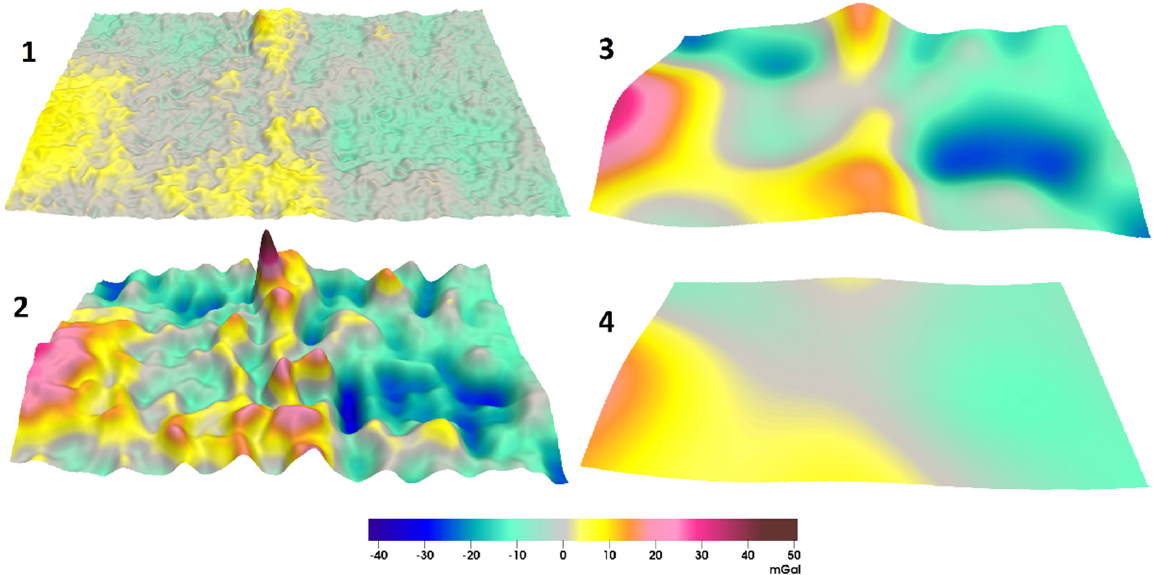
Figure 13. Examples of the noised different field separation. The ranges of depths of the layer are (1) H ∊ [0, 5] km, Δ g ∊ [ − 9.7, 13.8] mGal; (2) H ∊ [5, 20] km, Δ g ∊ [ − 33.0, 50.2] mGal; (3) H ∊ [20, 40] km, Δ g ∊ [ − 25.6, 33.5] mGal; and (4) H ∊ [40,80] km, Δ g ∊ [ − 11.8, 17.1] mGal.